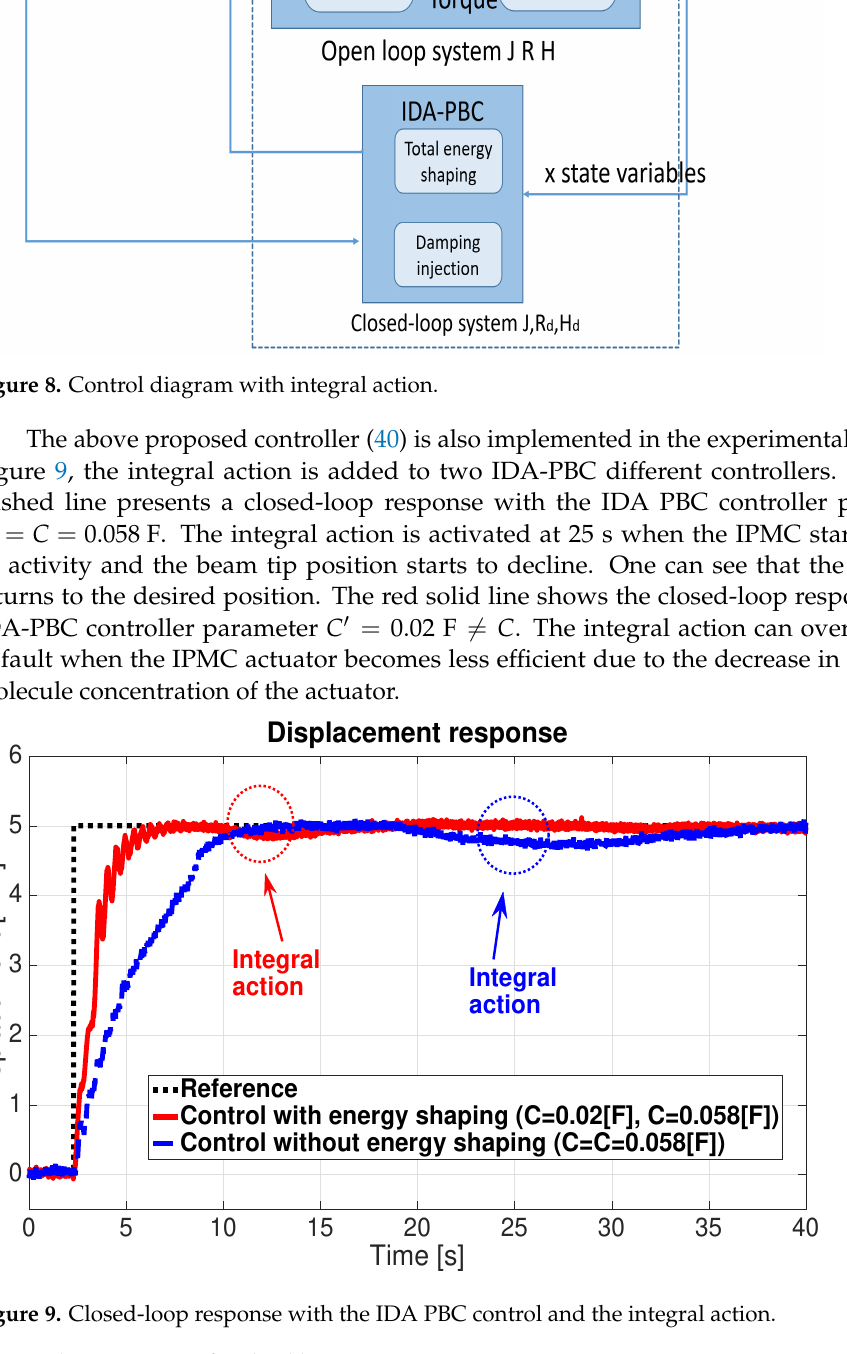
Figure 9. Closed loop response with the IDA PBC control and the integral action. Figure 9. Closed-loop response with the IDA PBC control and the integral